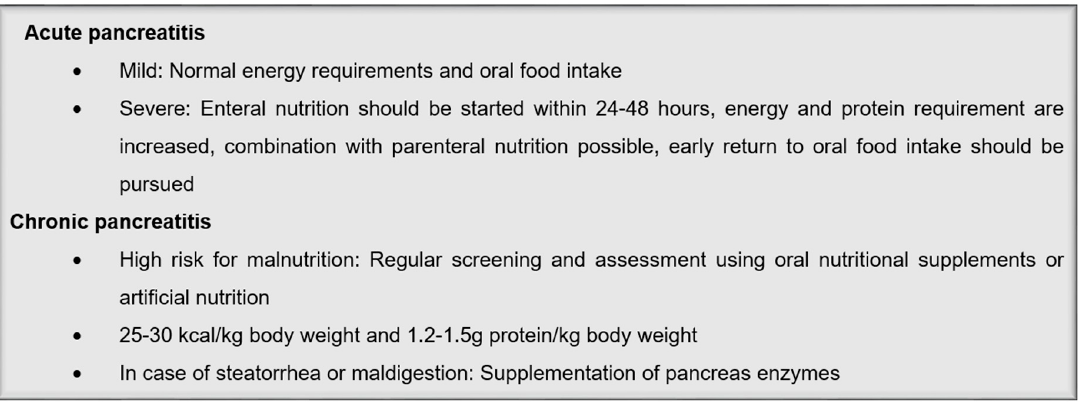
Figure 2. Summary of nutritional recommendations in pancreatic disease.